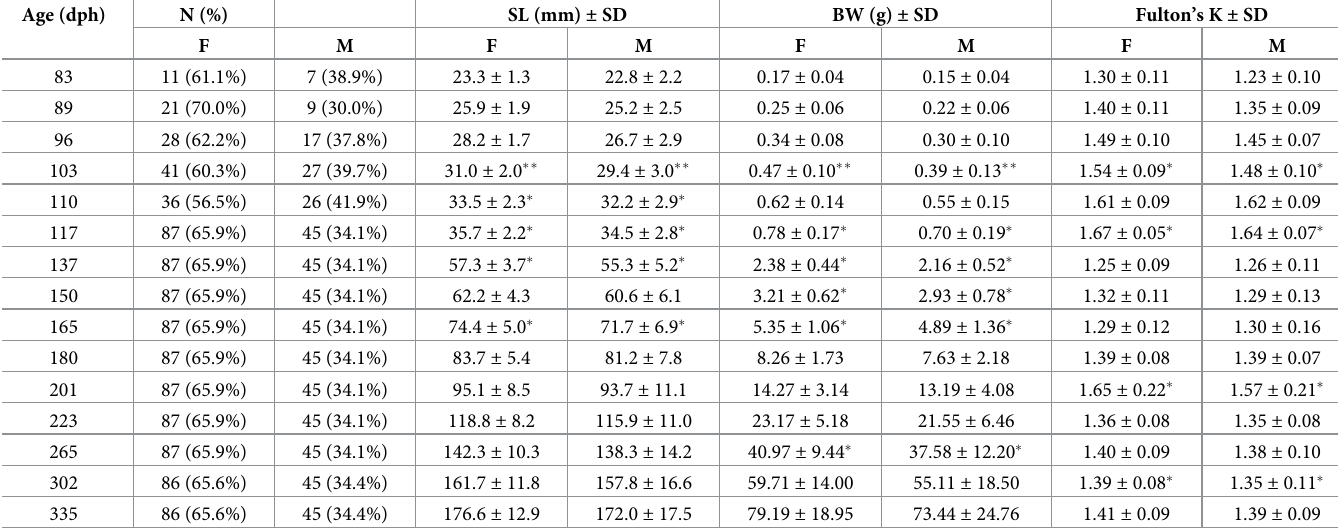
Table 1. Body weight, standard length, and Fulton’s body condition factor K.